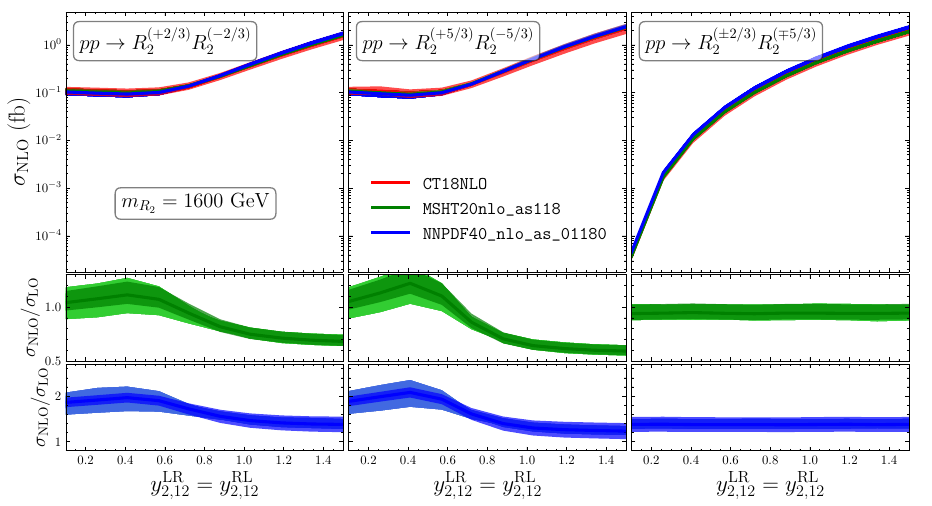
Figure 2 . Total cross sections for the production of a pair of R 2 eigenstates as a function of y = y LR = y RL for the three processes pp → R (+2 / 3) R ( − 2 / 3) (left), pp → R (+5 / 3) R ( − 5 / 3) (middle) 2 , 12 2 , 12 2 2 2 2 and pp → R ( ± 5 / 3) R ( ∓ 2 / 3) (right). In the lower panels, we present NLO K -factors defined as the 2 2 ratio of the NLO rates to the LO ones for the MSHT20 and NNPDF4.0 PDF sets. Our predictions include scale (light error bands) and PDF (darker error bands) uncertainties at NLO (evaluated relatively to the central LO predictions for the K